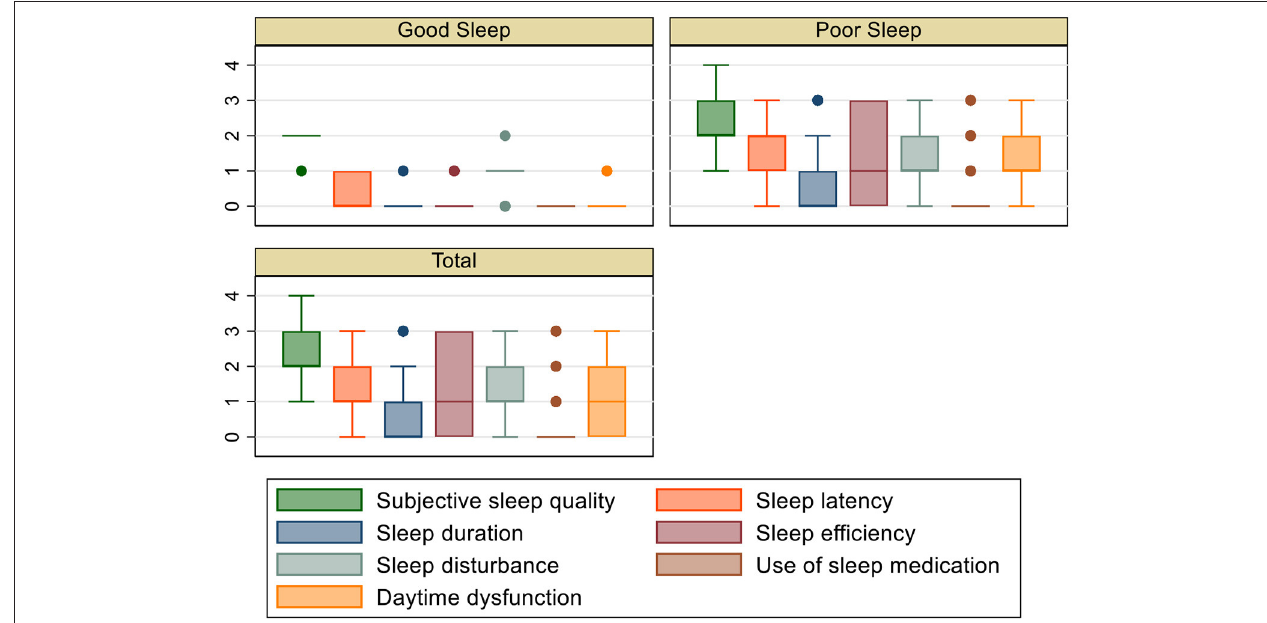
FIGURE 1 | Box plot of PSQI components in participants with good and poor